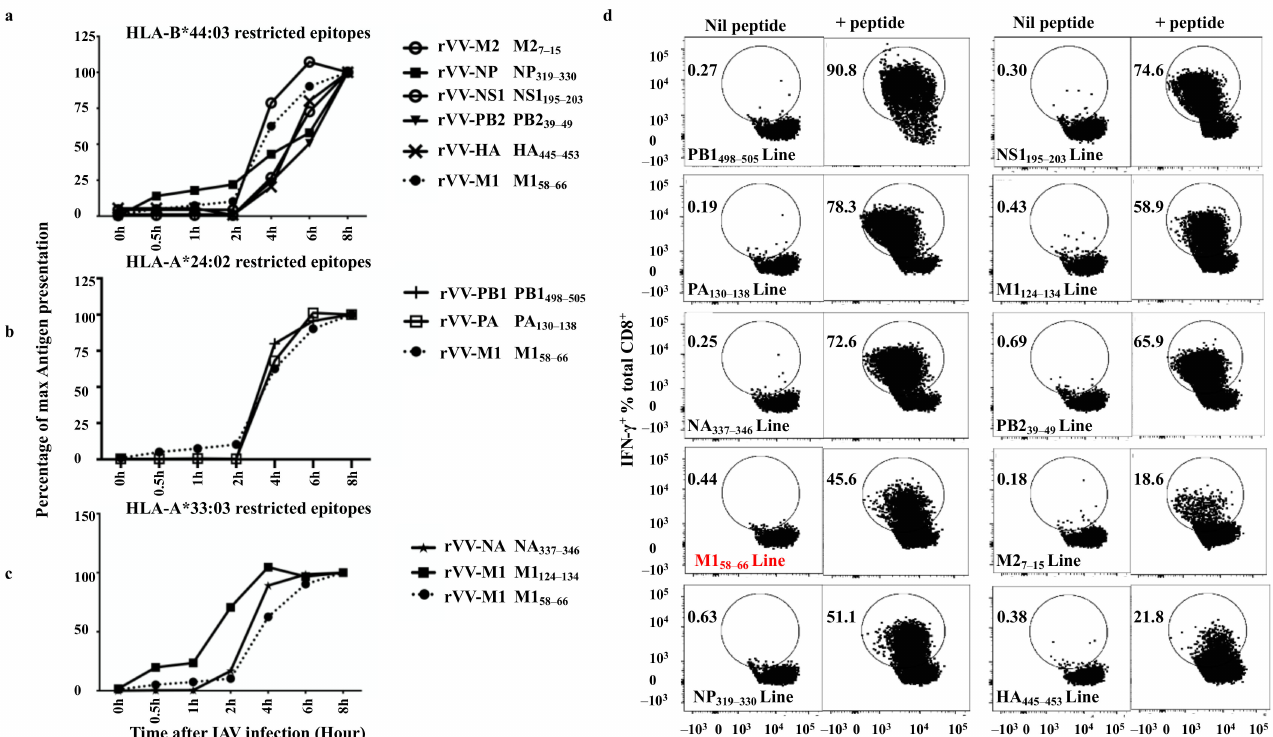
Figure 5. Most novel CD8 + T cell epitopes are presented with a fast kinetics. CD8 + T cells were activated by rVV-infected BLCLs at various time points (0, 0.5, 2, 4, 6, and 8 h) after the first-hour infection, then BFA and T cells were added to “freeze” and read out antigen presentation at that time point after rVV infection. The antigen presentation, reflected by the amount of epitope-specific T cell activation was assessed for IFN- γ production by ICS as described in the method. ( a ) HLA-B*44:03 restricted epitope presentation is compared to that of a well-studied immunodominant epitope M1 58–66 (shown in dotted line). ( b ) HLA-A*24:02 restricted epitope presentation is compared to that of M1 58–66 (shown in dotted line). ( c ) HLA-A*33:03 restricted epitope presentation is compared to that of M1 58–66 (shown in dotted line). This experiment was performed and analysed together. For clarity, the results are displayed according to single HLA restriction of the epitopes. Data shown are representative of two independent experiments with similar results. ( d ) The FACS profiles showing the purities of the CD8 + T cell lines specific for PB1 498–505 , NS1 195–203 , PA 130–138 , M1 124–134 , NA 337–346 , PB2 39–49 , M1 58–66 , M2 7–15 , NP 319–330 , and HA 445–453 used in ( a – c ). Nil peptide: APC only control; +peptide: APCs were pulsed with each individual peptide at 10 − 6 M for 1 h in RF-10 before being incubated with antigen-specific CD8 + T cells and assessed in a standard